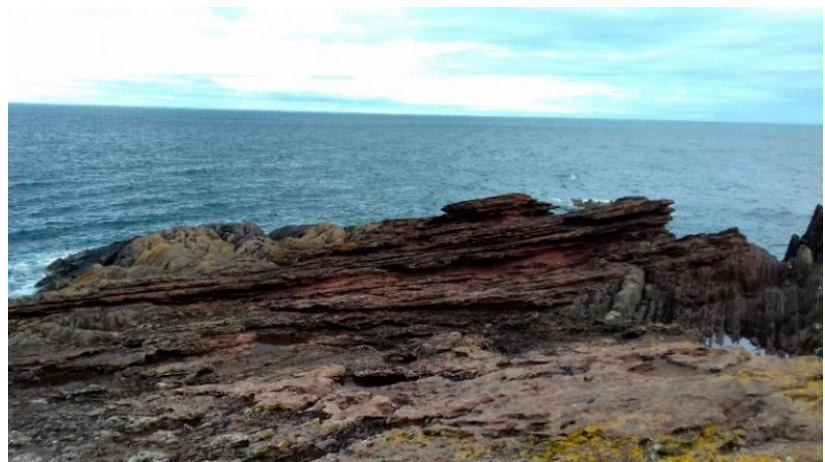
Figure 5. Unconformity at Siccar Point, Berwickshire. Image, author’s own.